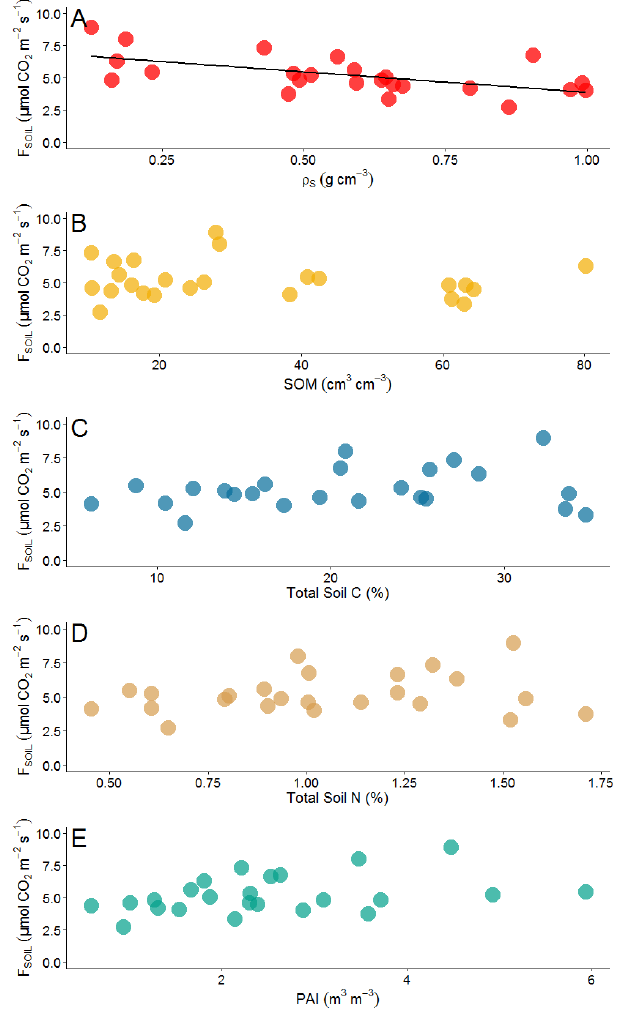
Figure 5. (a) Soil bulk density (gcm − 3 ) ; (b) soil organic mat- ter (%); (c) total soil carbon (%); (d) total soil nitrogen (%), and (e) plant area index (m − 3 m 3 ) against mean plot-level soil CO 2 ef- flux by plot for all measurements across all 3 years in which soil temperature ( ◦ C) was above 11 ◦ C. Only soil bulk density (a) shows a significant relationship ( R 2 = 0.302; p = 0.003) with mean plot- level soil CO 2